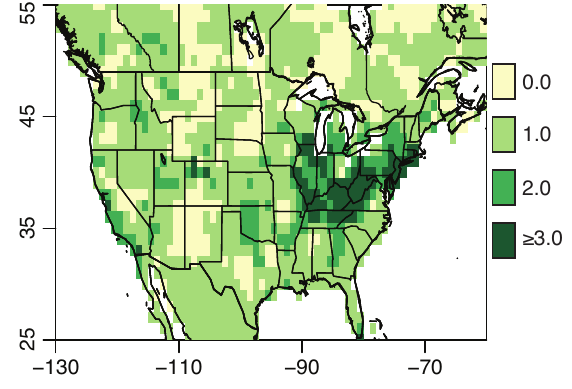
Fig. 3. The number of posterior uncertainty standard deviations before the methane emissions become negative in the unconstrained estimate.